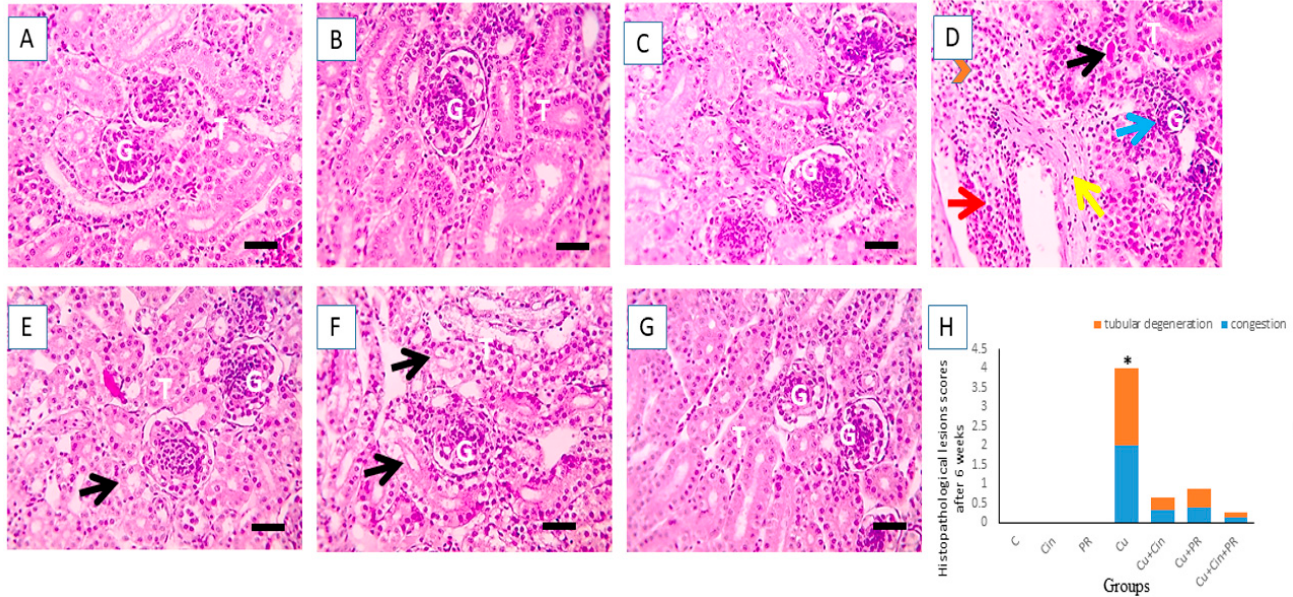
Figure 6. Light photomicrographs of chicken kidney sections (stained with H&E, X 400) after 6 weeks of the experiment. ( A – C ) Control group ( C ), cinnamon group (Cin), and probiotic group (PR): showing normal glomeruli (G) and tubules (T). ( D ) Copper group (Cu): elucidating tubular casts (black arrow), atrophied glomeruli (blue arrows), congested blood vessels (red arrows), perivascular hemorrhage (red arrowheads), and fibrosis (yellow arrow). ( E ) Cu + Cin group: showing very mildly vacuolated tubular epithelium (black arrows). ( F ) Cu + PR group: revealing moderately vacuolated tubular epithelium (black arrows). ( G ) Cu + Cin + PR group: Retained normal appearance of tubules and glomeruli. ( H ) Semiquantitative scoring of renal tubular degeneration and congestion. * Significance compared to control ( p < 0.05). Scale bar = 50 µm.